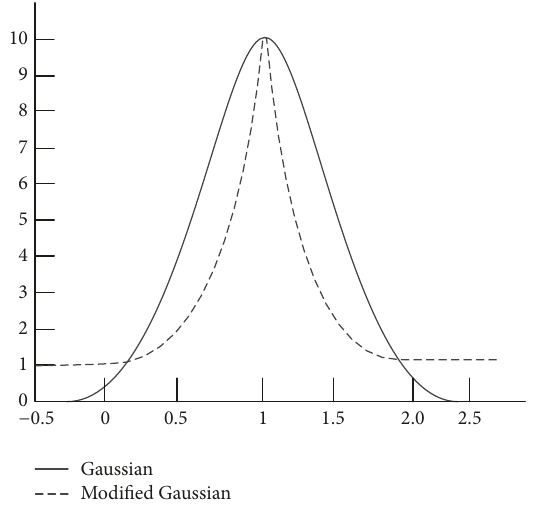
Figure 4: Characteristics of the two functions.